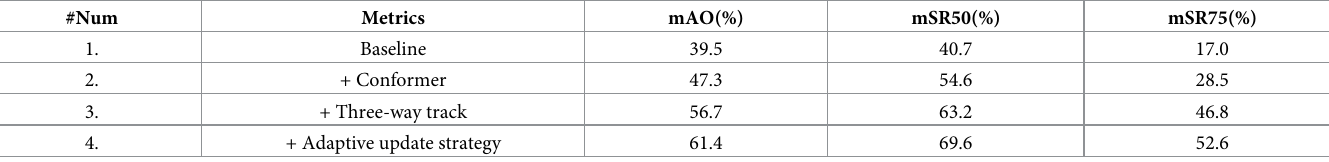
Table 6. Component-wise analysis. Performance is evaluated on GOT-10K.